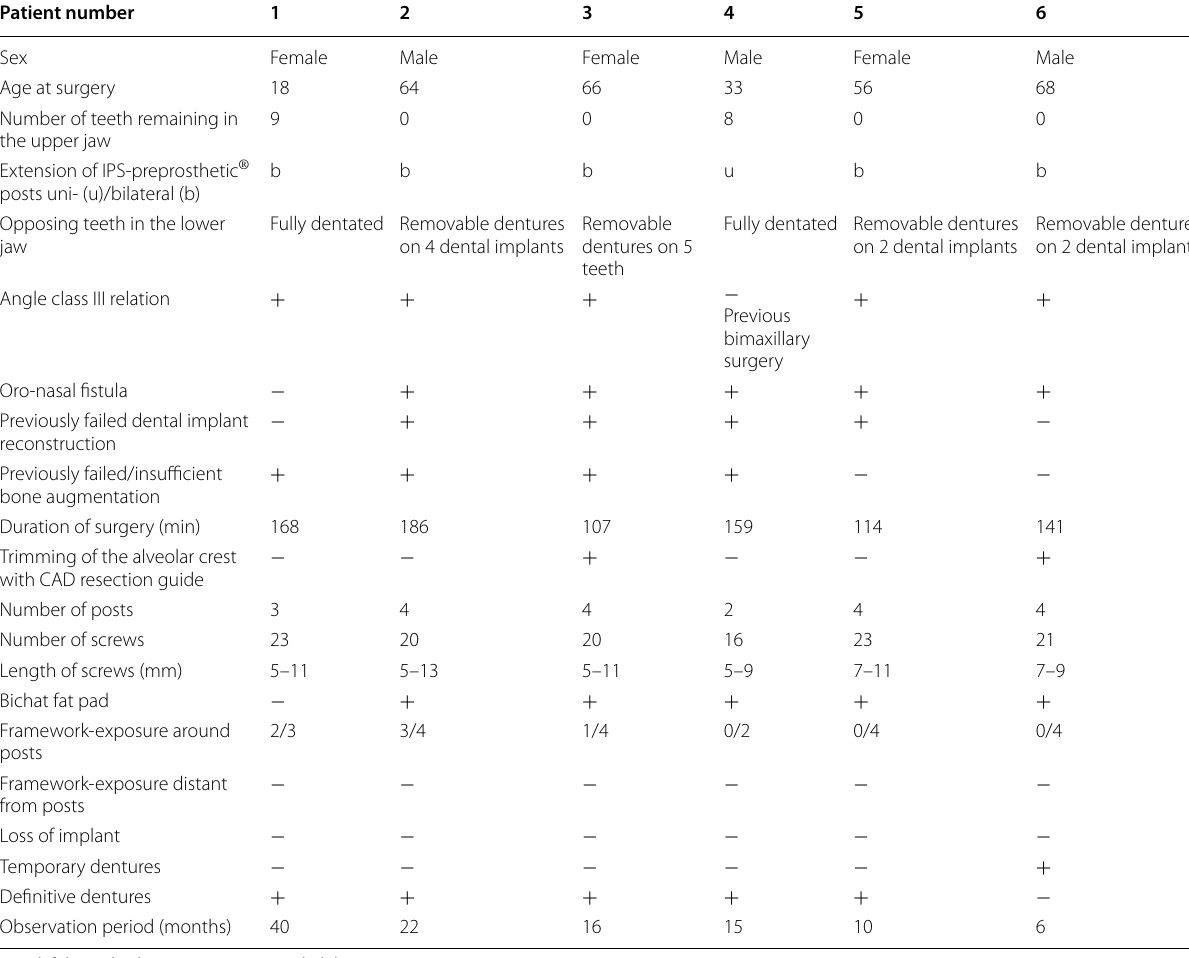
Table 2 Distribution of the CLP patients undergoing IPS‑preprosthetic ® treatment